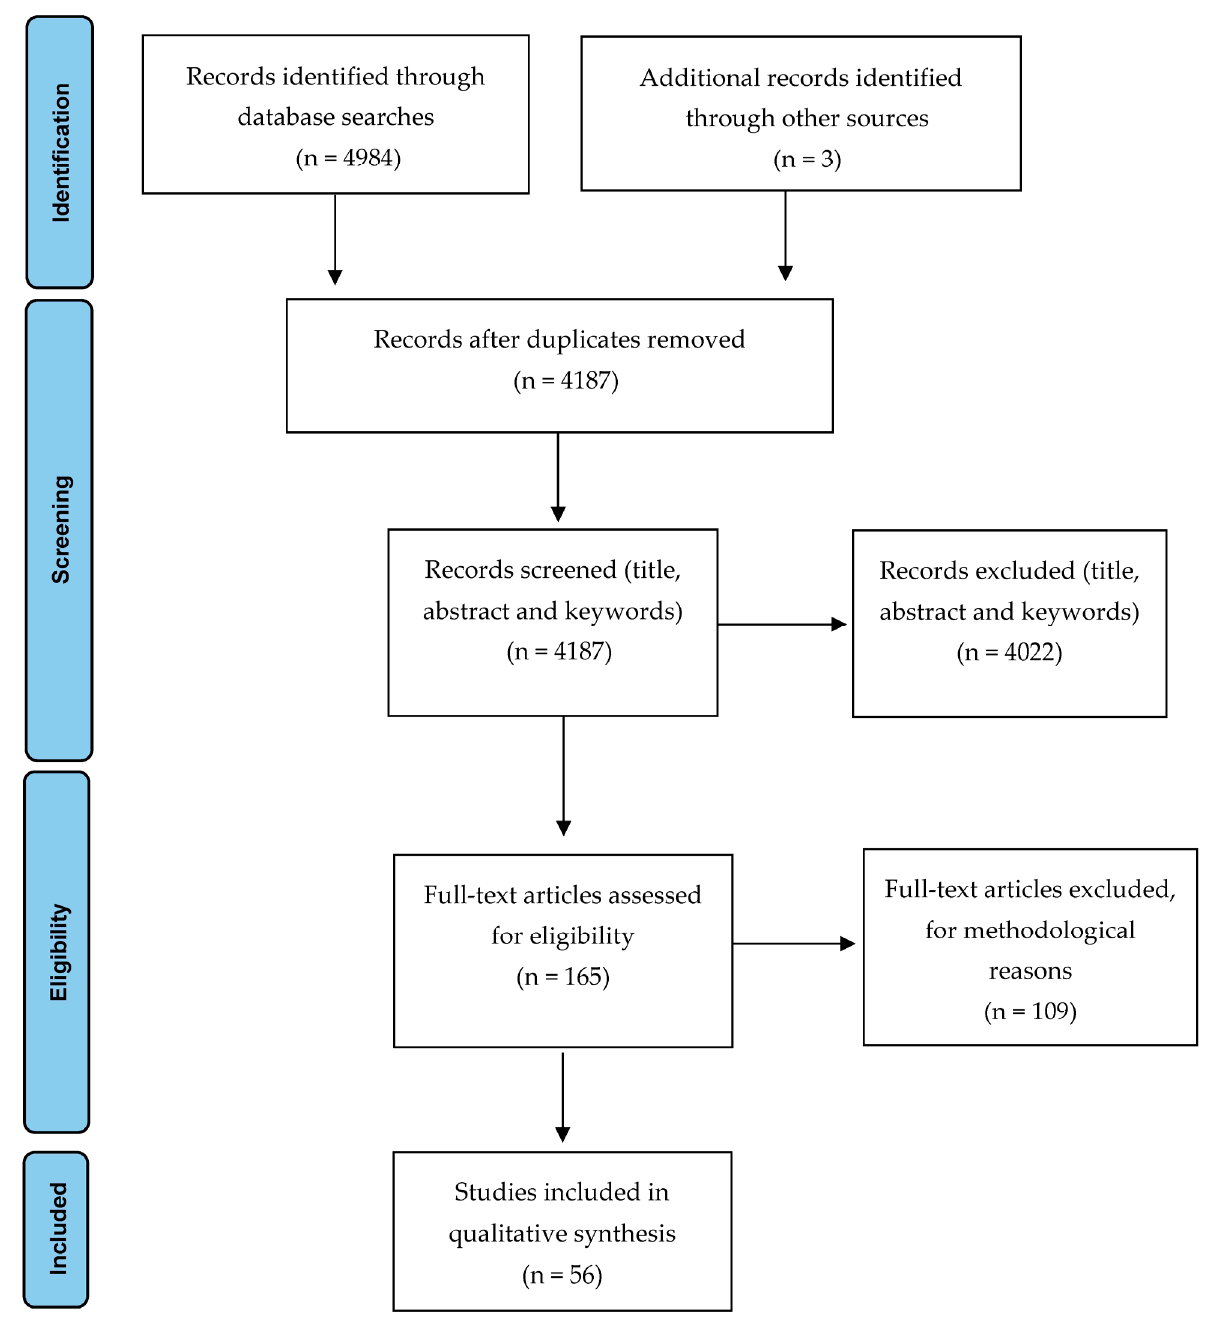
Figure 1. PRISMA Flow Diagram [44]. For more information, visit www.prisma-statement.org accessed on 26 May